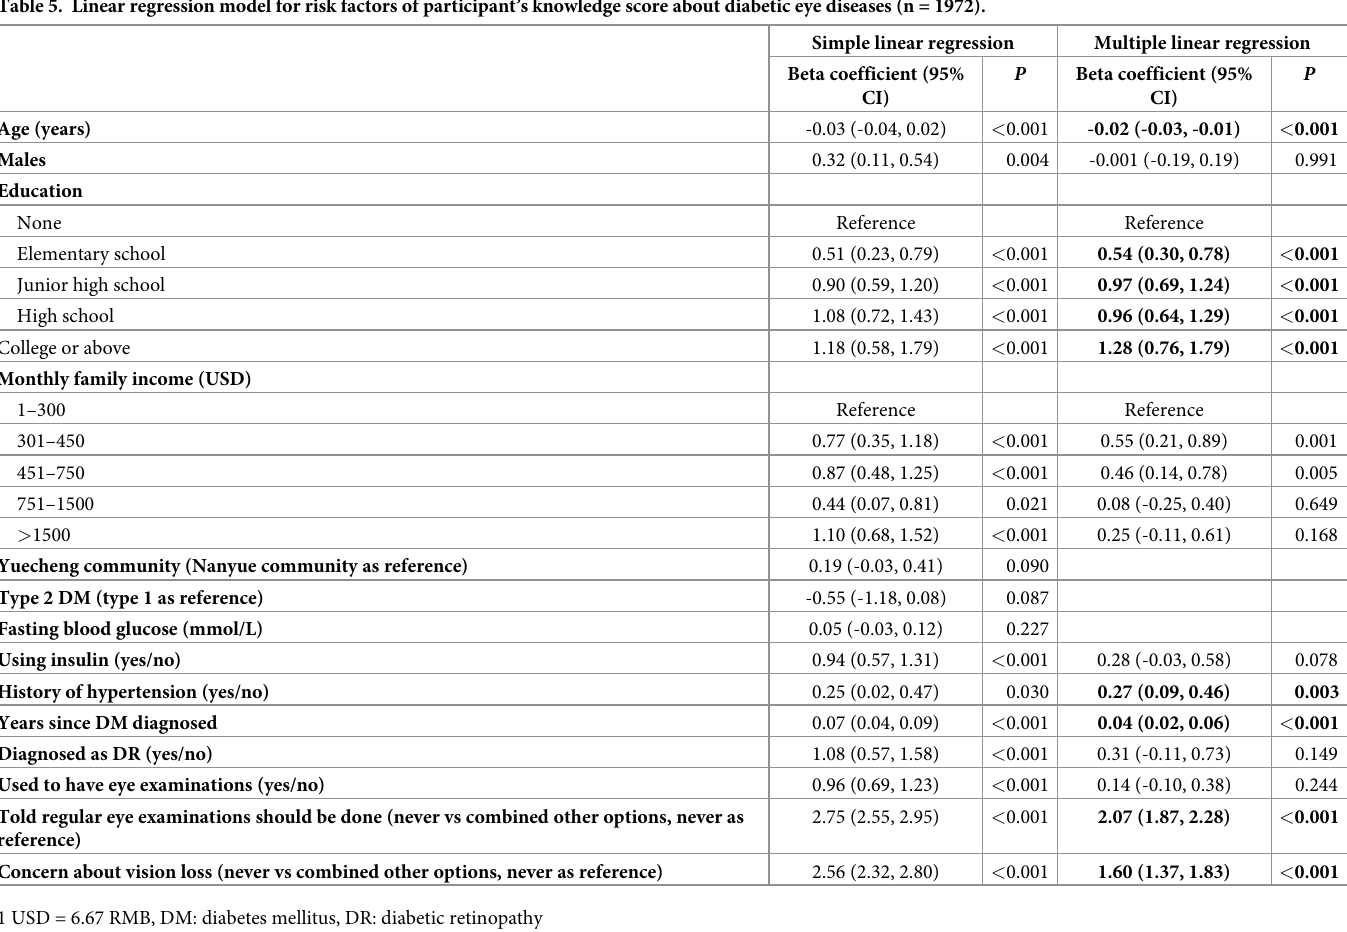
Table 5. Linear regression model for risk factors of participant’s knowledge score about diabetic eye diseases (n = 1972).